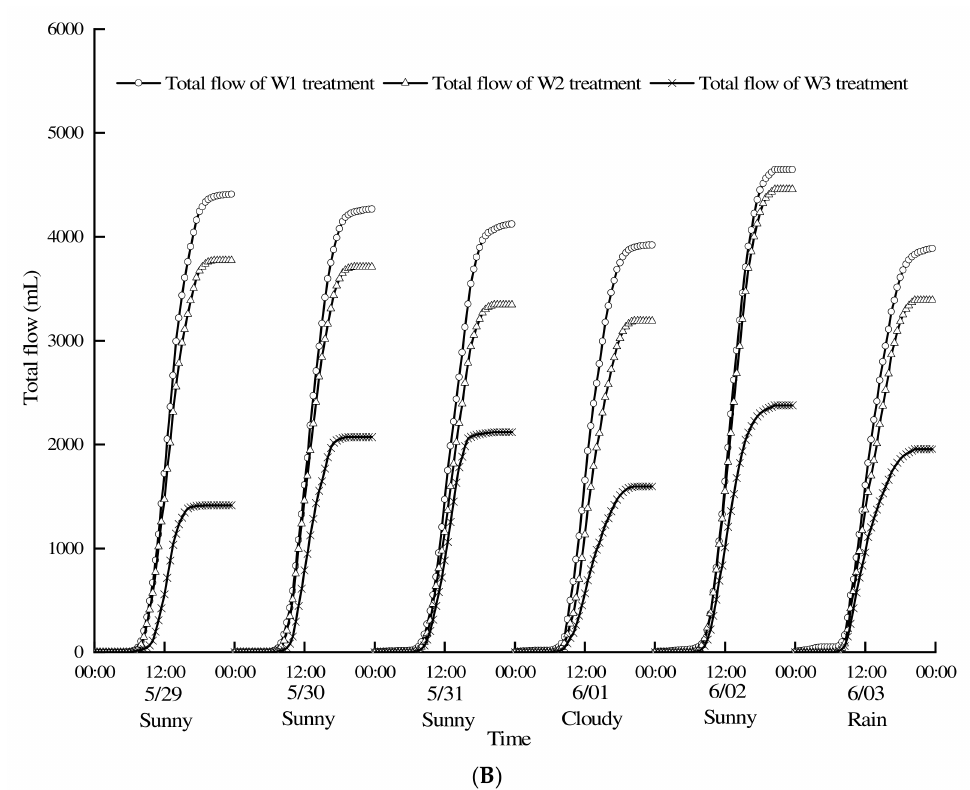
Figure 3. ( A ) Diurnal variation in sap flow rate (Sap.W1, Sap.W2 and Sap.W3 represents an average of measurements of sap flow rate from two grape trees of W1, W2 and W3 treatments, respectively), Ra (solar radiation) and VPD (vapor pressure deficit); ( B ) sap flow accumulation curve in different irrigation